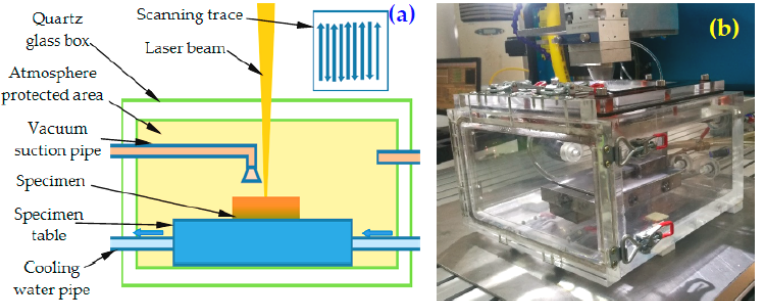
Figure 2. Schematic diagram ( a ) and the apparatus of quartz glass atmosphere protection device ( b ) for